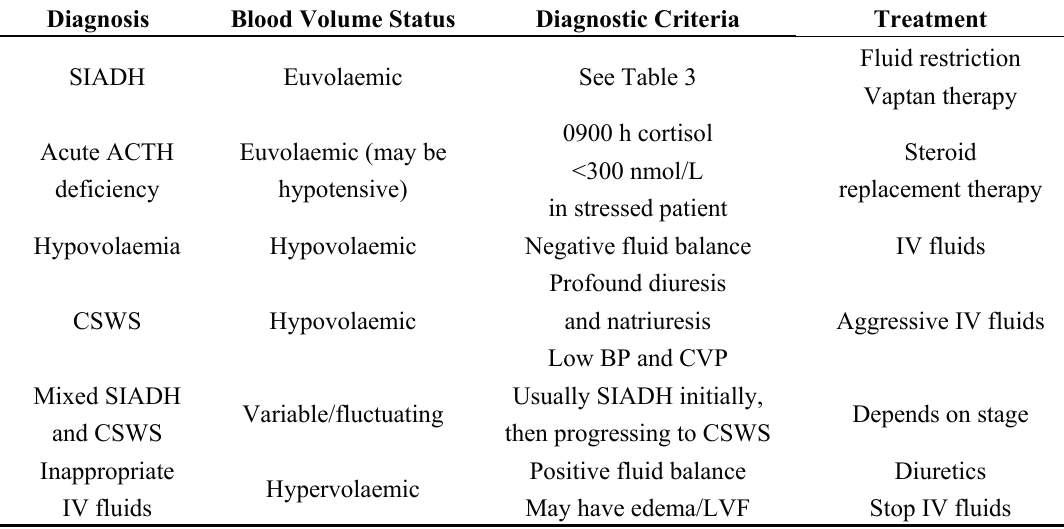
Table 2. The etiology, diagnosis and basic management of neurosurgical